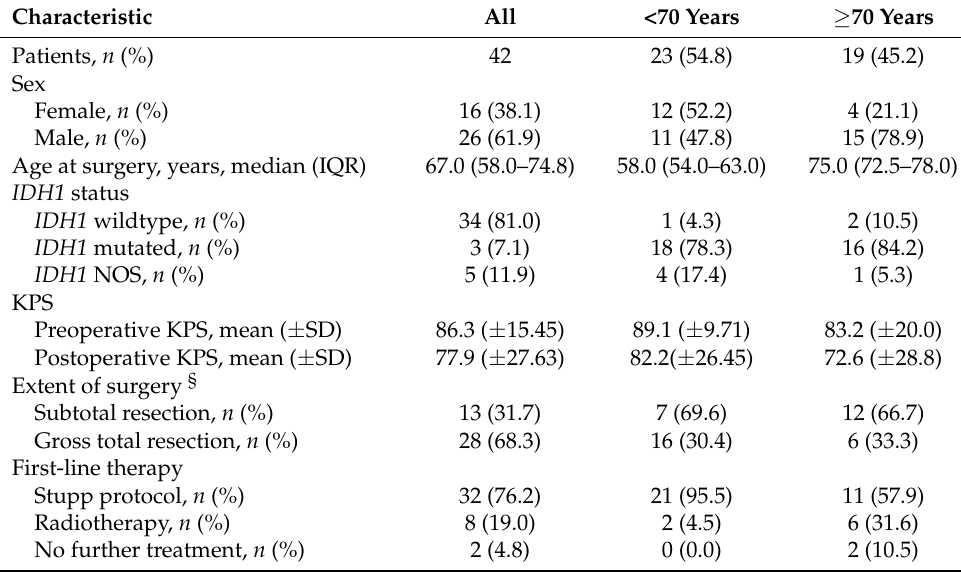
Table 1. Characteristics of patients with glioblastoma WHO grade IV. The characteristics are listed for all patients (All), patients younger than 70 years of age (<70 years) and patients with an age of 70 years or more ( ≥ 70